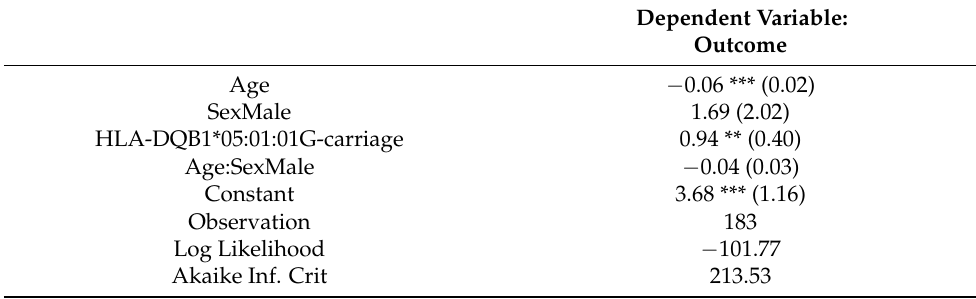
Table 15. Coefficients for one-allele (HLA-DQB1*05:01:01G)